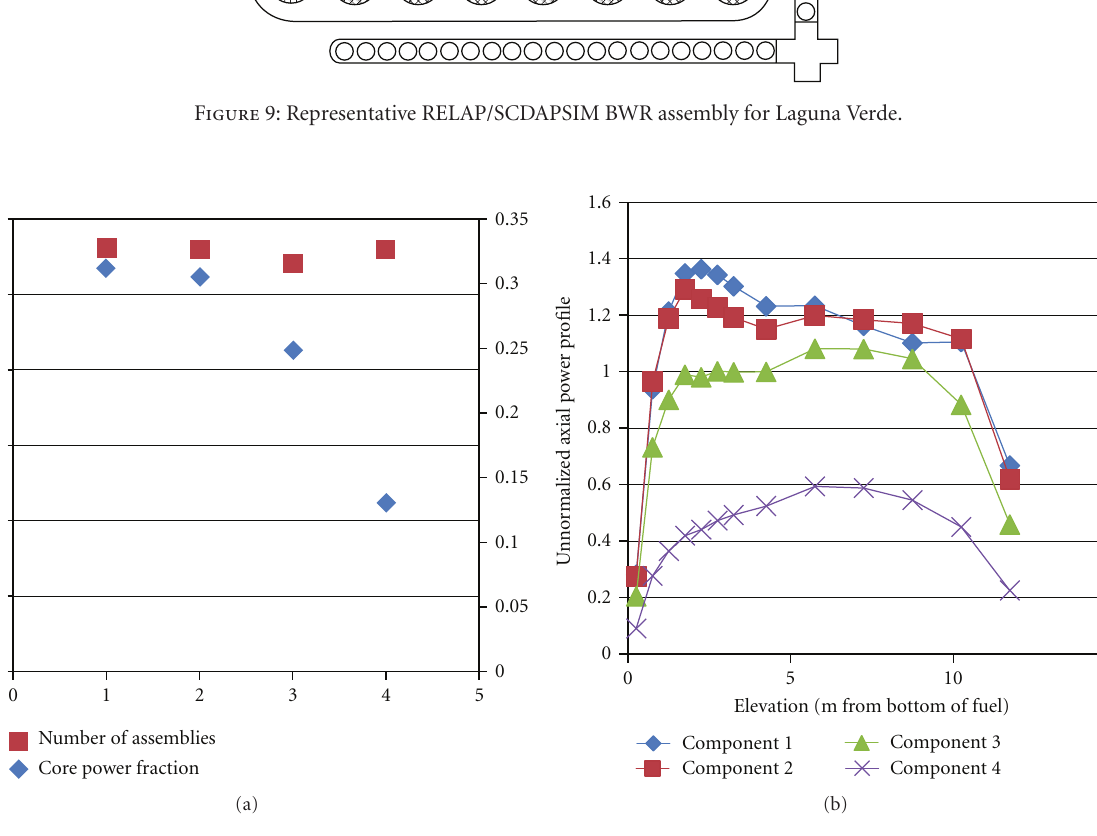
Figure 10: Description of the four representative assemblies used in the Laguna Verde input